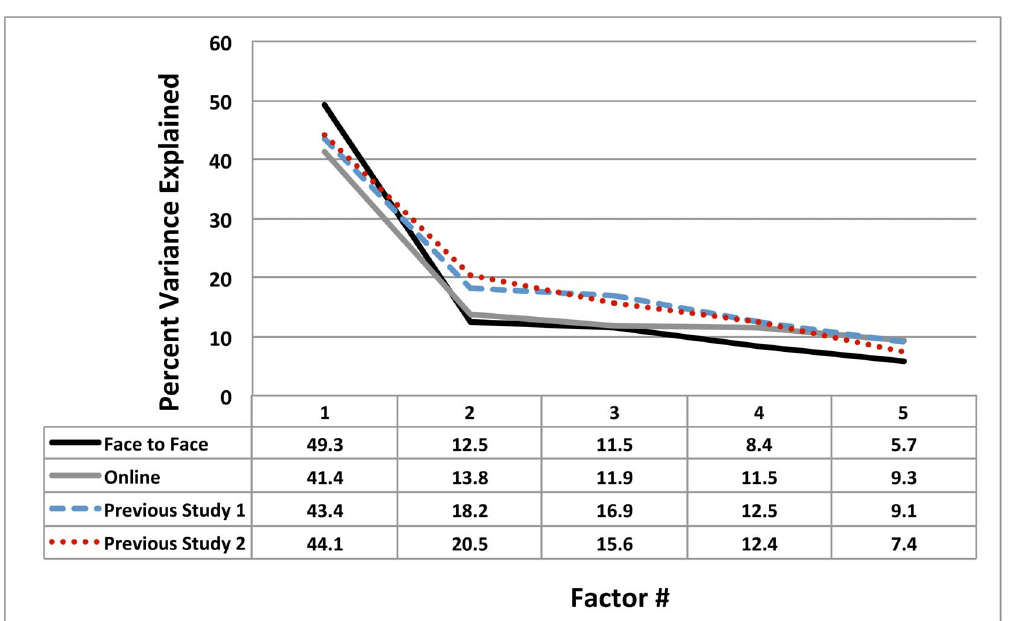
Fig. 2. Scree plot comparing the variance explained by the first five factors extracted from a factor analysis of group performance on each of the groups tasks in this study, as compared to the factor structures reported in Woolley et al.’s [11] study. The first factor (collective intelligence) explains over 40% of the variance in all cases, while the second factor accounts for less than half of this amount, and the remaining factors account for much less.